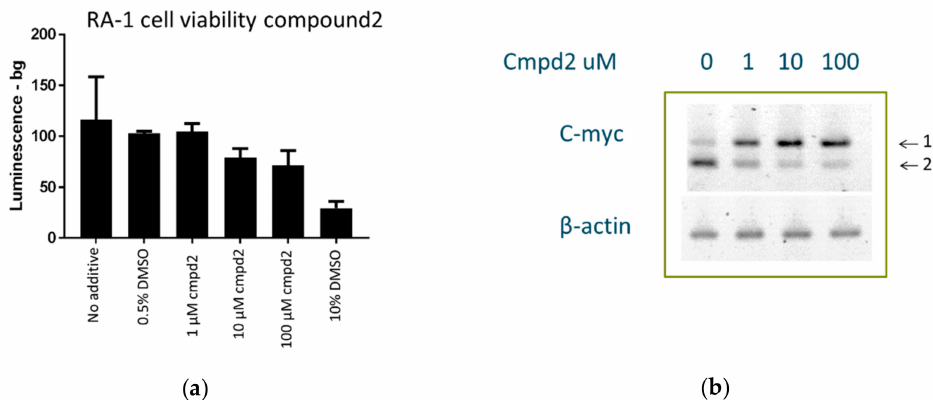
Figure 8. Viability of RA 1 cells (Burkitt’s lymphoma, dependent on c-myc): ( a ) 48-h cell viability in the presence of di ff erent concentrations of Compound 2 as determined by Cell Titer-Glo assay (Promega); ( b ) RT-PCR of c-myc expression in RA 1 cells after 24 h of treatment with di ff erent concentrations of Compound 2 . Here, 1: Full-length PCR product; 2: Primer-dimer. Full gels are presented in Figure